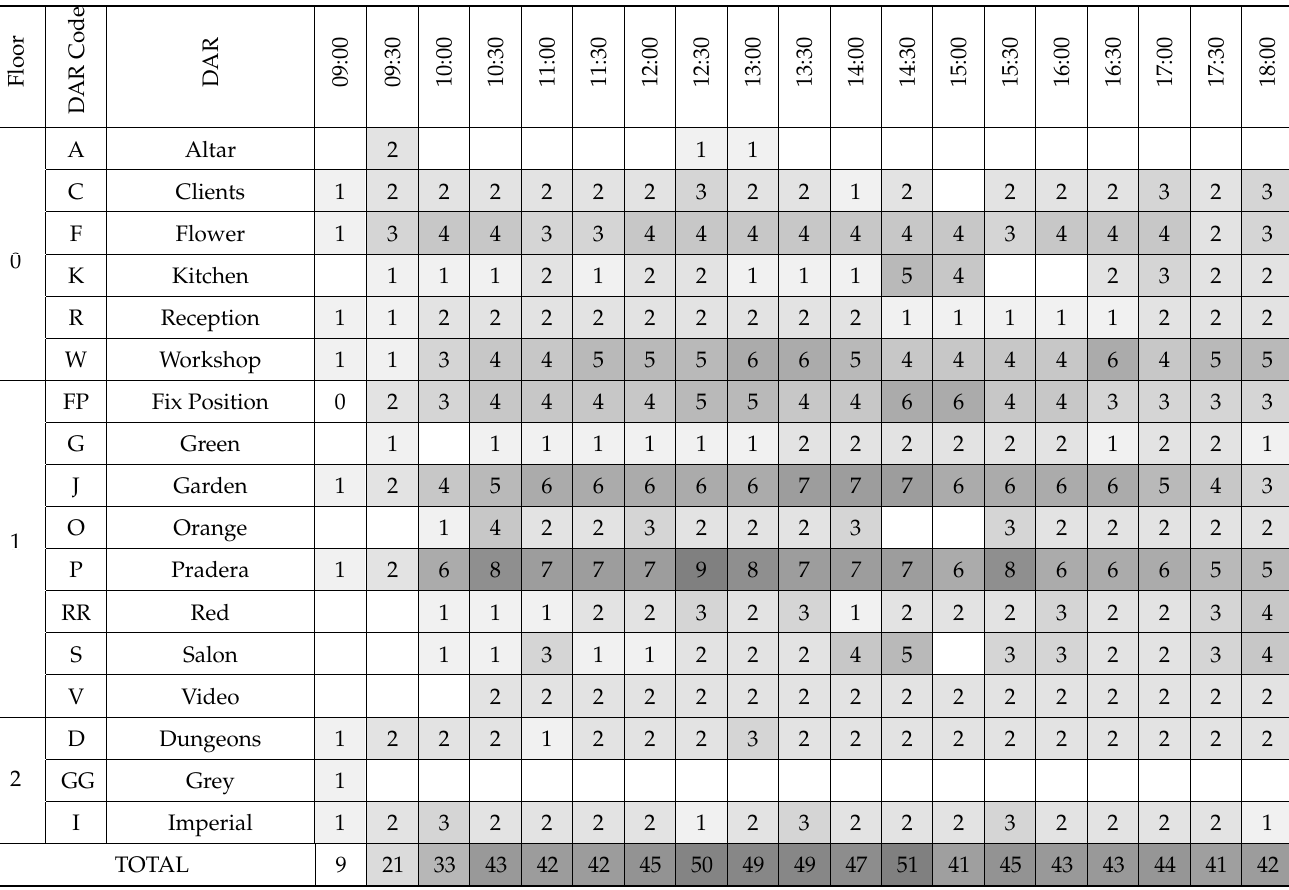
Table 3. Presence per DAR (quantitative manual data). Numbers indicate the number of employees present at each spaces per hour. Dark colors highlight the areas with more users present at a